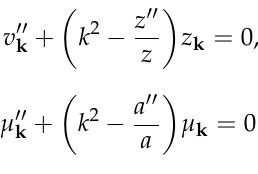
in the expanding −